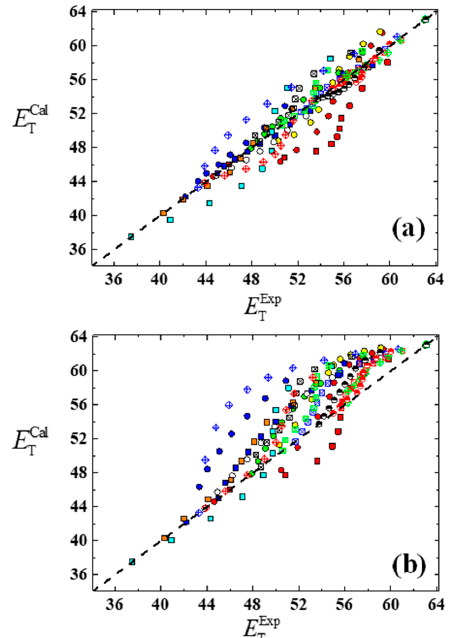
Figure 7. Parity plots of electronic transition ( E T ) in eighteen aqueous mixtures obtained from ( a ) the predictive model (Equation (2), R 2 = 0.91) and ( b ) the ideal model (Equation (1), R 2 = 0.81). Symbols and conditions are defined in Table 2.